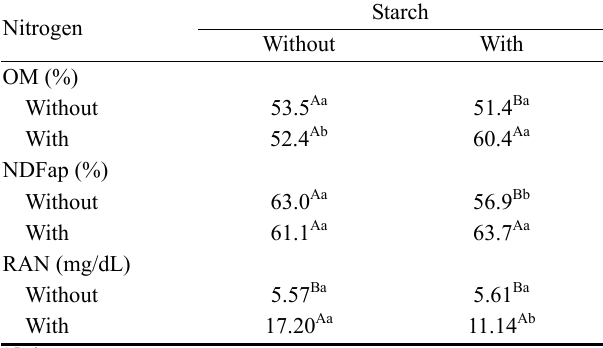
Table 5. Interaction between nitrogen and starch supplementation on total digestibilities of organic matter (OM) and